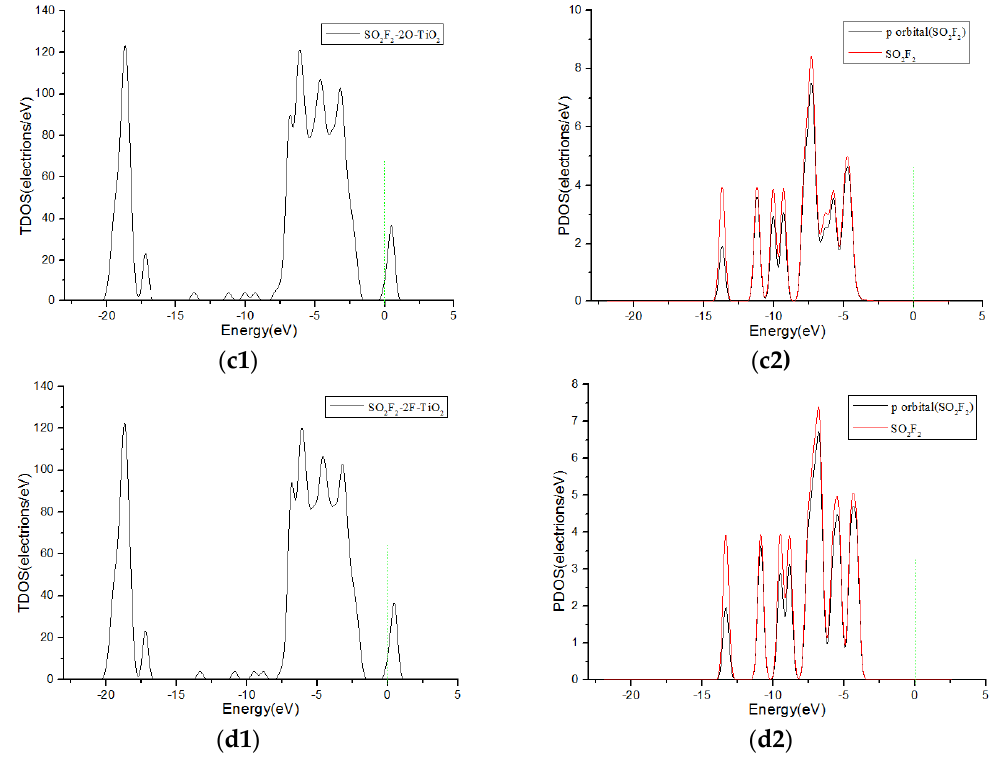
Figure 8. TDOS and PDOS of SO 2 F 2 molecules adsorbed on F-doped TiO 2 , and the green short dashed line is Fermi level. ( a1 , a2 ) are the TDOS and PDOS of SO 2 F 2 -O-TiO 2 , ( b1 , b2 ) are the TDOS and PDOS of SO 2 F 2 -F-TiO 2 , ( c1 , c2 ) are the TDOS and PDOS of SO 2 F 2 -2O-TiO 2 , ( d1 , d2 ) are the TDOS and PDOS of SO 2 F 2 -2F-TiO 2 .